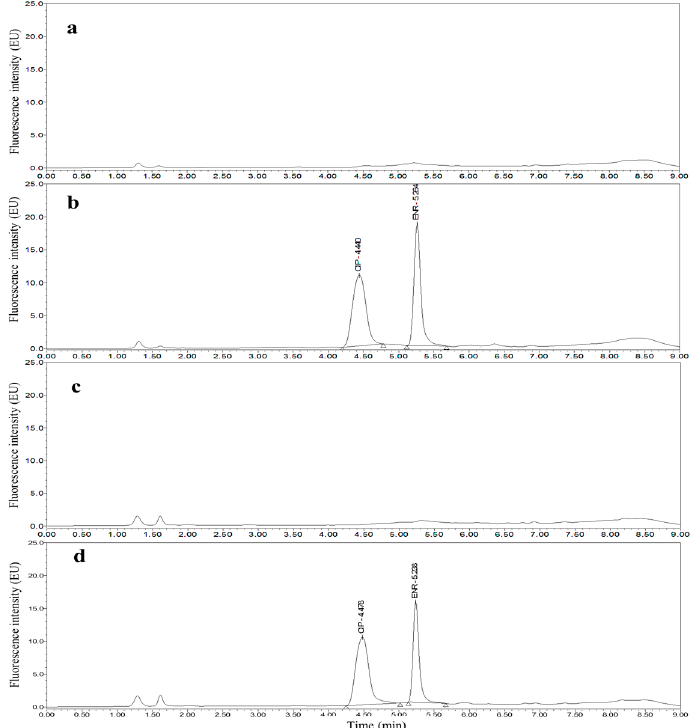
Figure 5. Chromatograms of the mobile phase ( a ), 200 μ g/kg OTC, TC and DOX standards ( b ), blank chicken yolk ( c ) and blank chicken yolk spiked with 200 μ g/kg OTC, TC and DOX standards ( d ) from channel A.